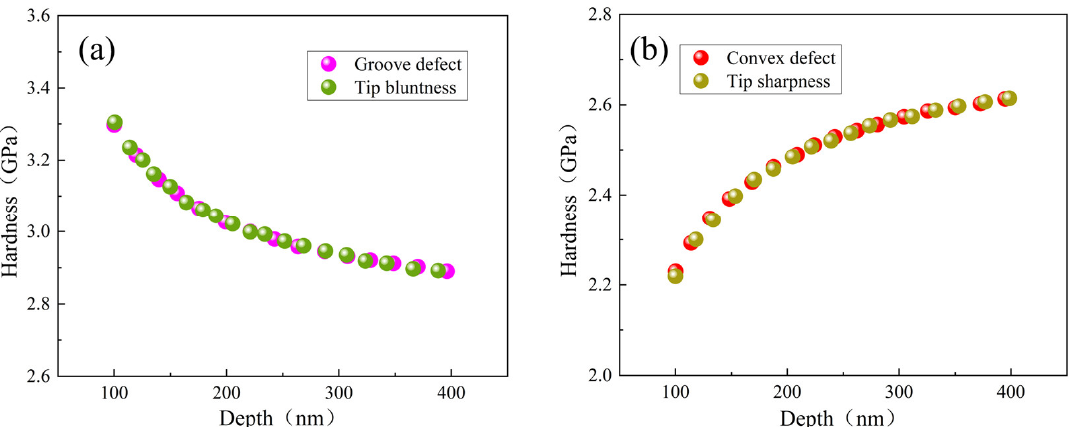
Figure 13. Comparison of hardness–depth dependence: ( a ) groove defect and tip bluntness; ( b ) con- vex defect and tip sharpness.